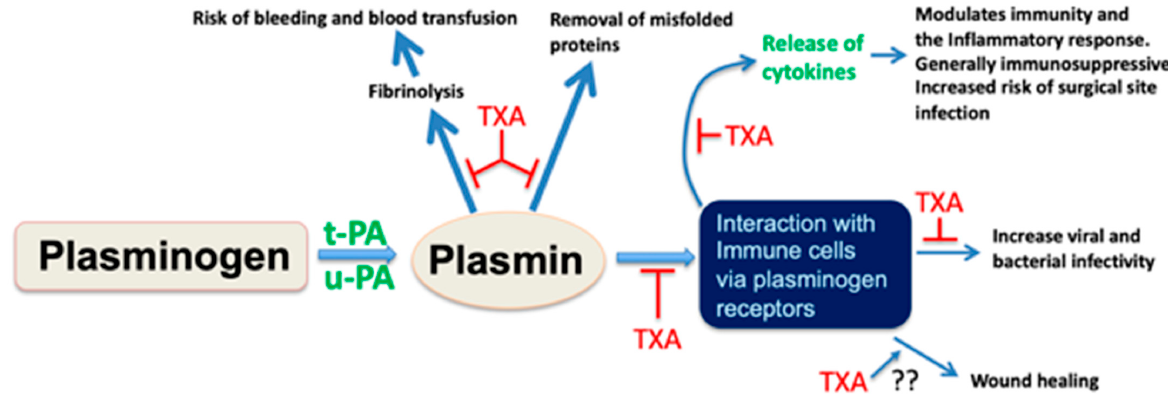
Figure 1. The generation of plasmin from its precursor, plasminogen is achieved by the plasminogen activators, tissue-type plasminogen activator, and urokinase (tPA and uPA, respectively). Plasmin once formed can cleave fibrin and other misfolded proteins. Excessive plasmin formation can result in hyperfibrinolysis, which increases the risk of bleeding and blood transfusion needs. Plasmin can also be formed on cell surfaces, including immune cells, via specific plasminogen receptors. This can result in the release of various cytokines with subsequent effects on cell behavior, inflammation, and immunity. Tranexamic acid (TXA) blocks lysine-dependent interactions and therefore inhibits binding of plasminogen to the surface of fibrin and misfolded proteins. The protection and stabilization of fibrin by TXA also reduces bleeding risk and transfusion requirements. Plasminogen receptors located on the surface of immune cells also contain C-terminal lysine residues that are important for plasminogen binding and subsequent cell activation. Hence, TXA can inhibit this interaction and therefore block downstream signaling events and cytokine release. It remains to be determined whether TXA blocks wound healing, although the transient administration of TXA in most clinical settings makes this unlikely.